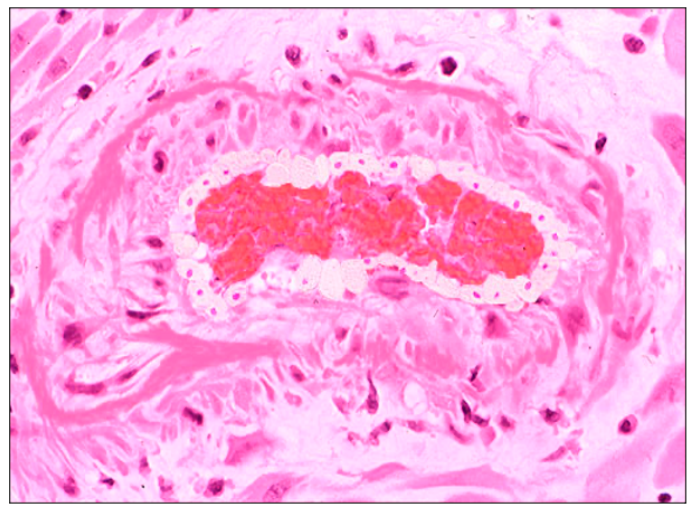
Figure 1. Signs of MVM in placenta from woman with SARS-CoV-2 infection: spiral artery atherosis with lipid laden macrophages (hematoxylin-and-eosin stain; original magnification 25×).